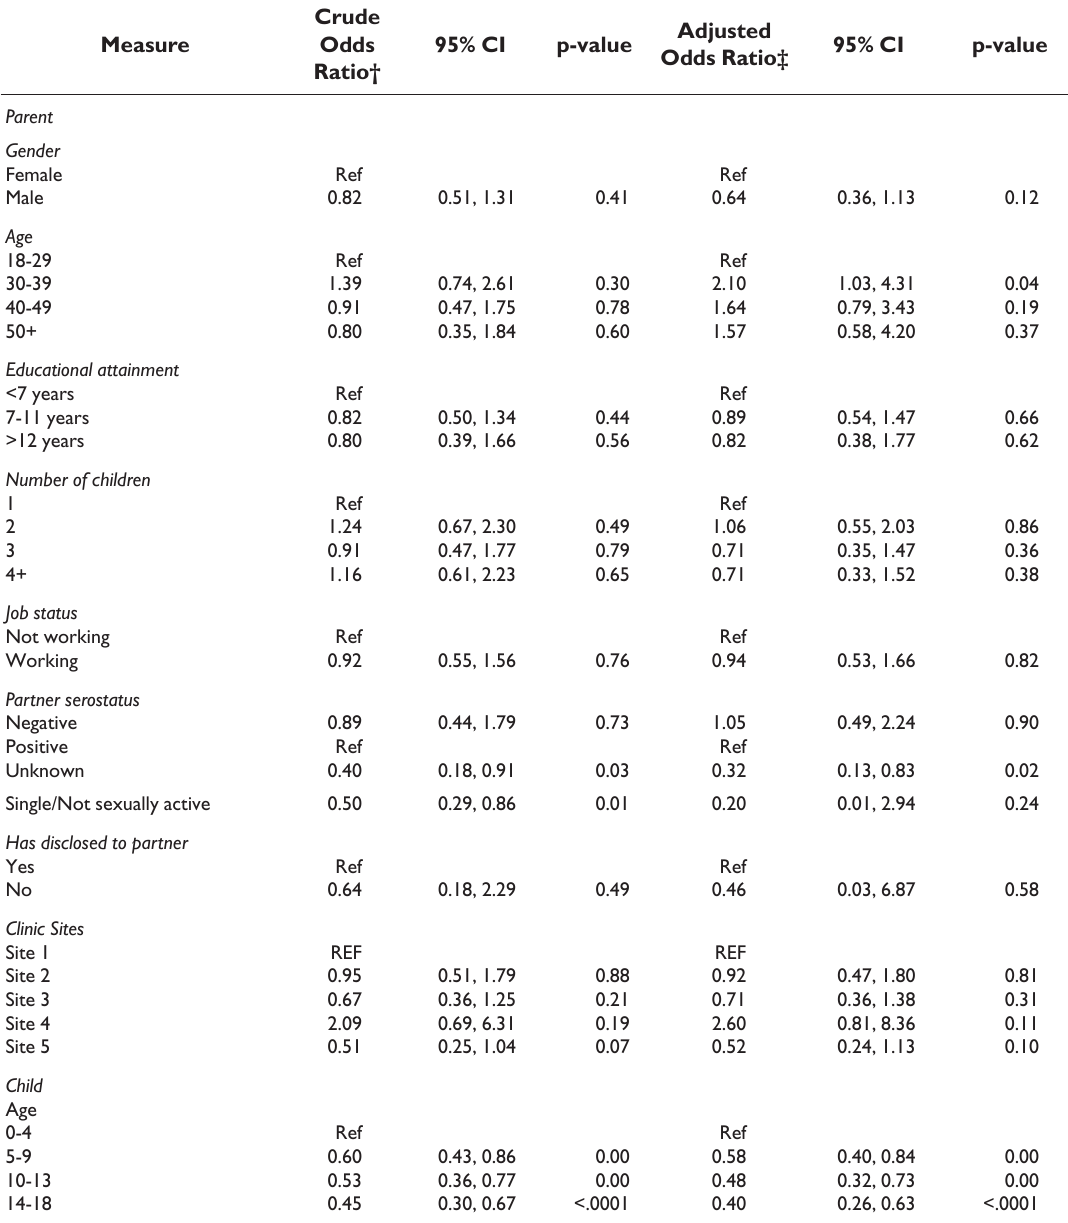
Table 2 Crude and adjusted odds ratios for association between parent and child measures with child testing status using generalized estimating equations (n=933¥)